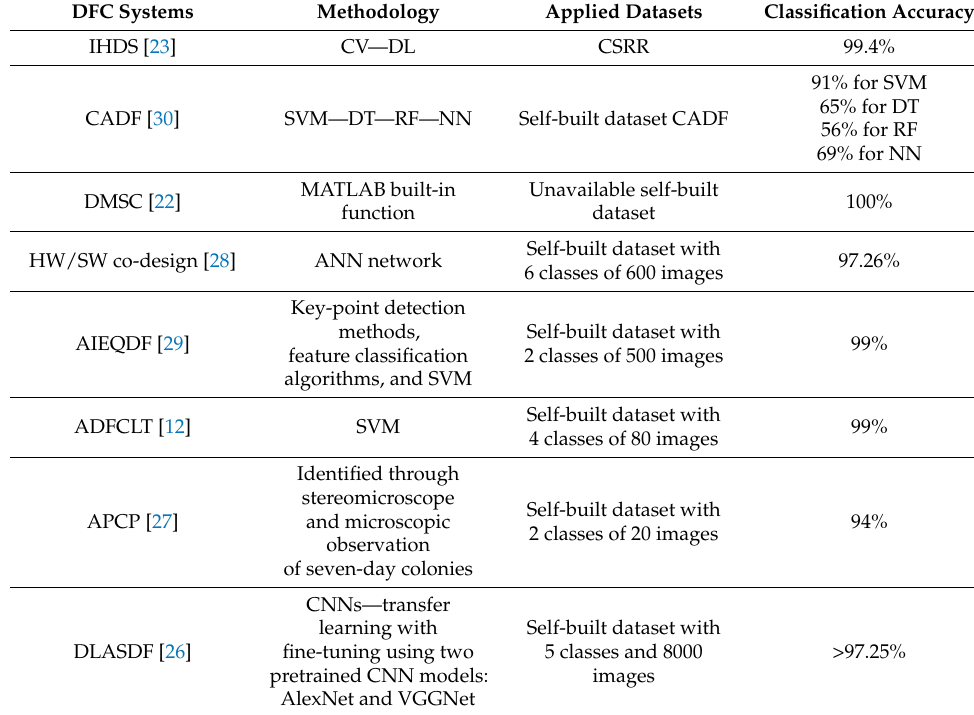
Table 5. Accuracy Comparison for different classification